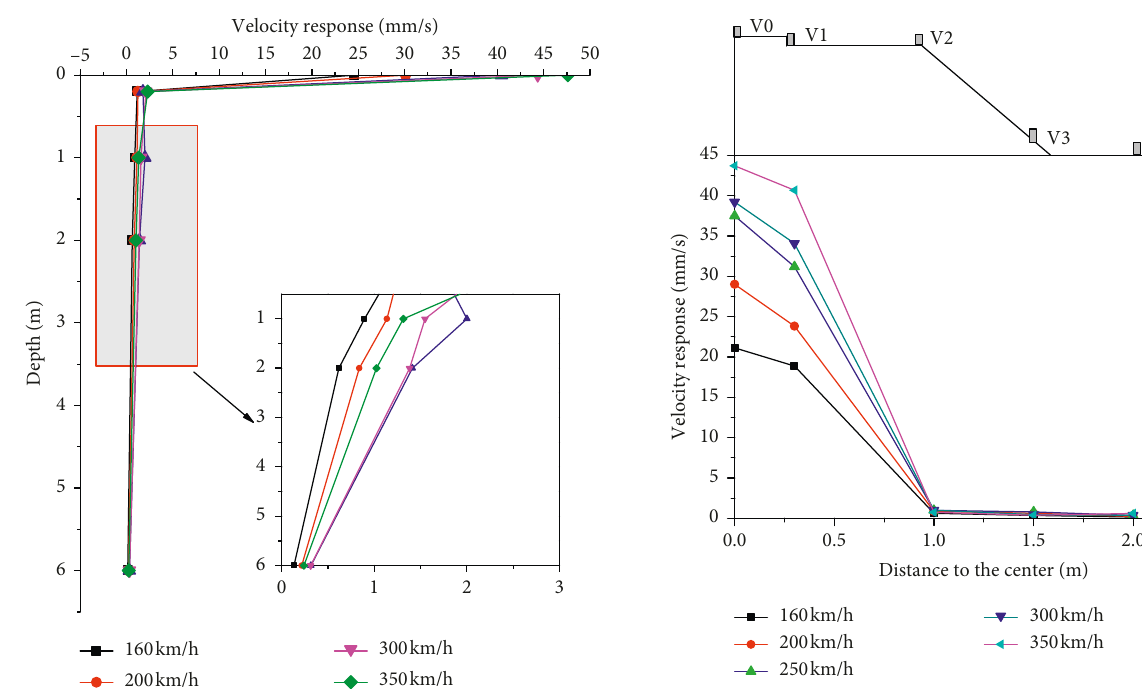
Figure 8: Vertical velocity with respect to horizontal dimension.